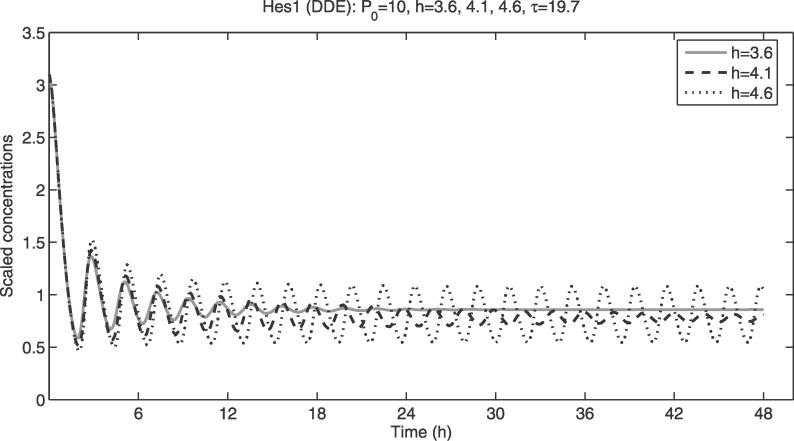
DDE Solution: Exploring the Effect of h on Protein